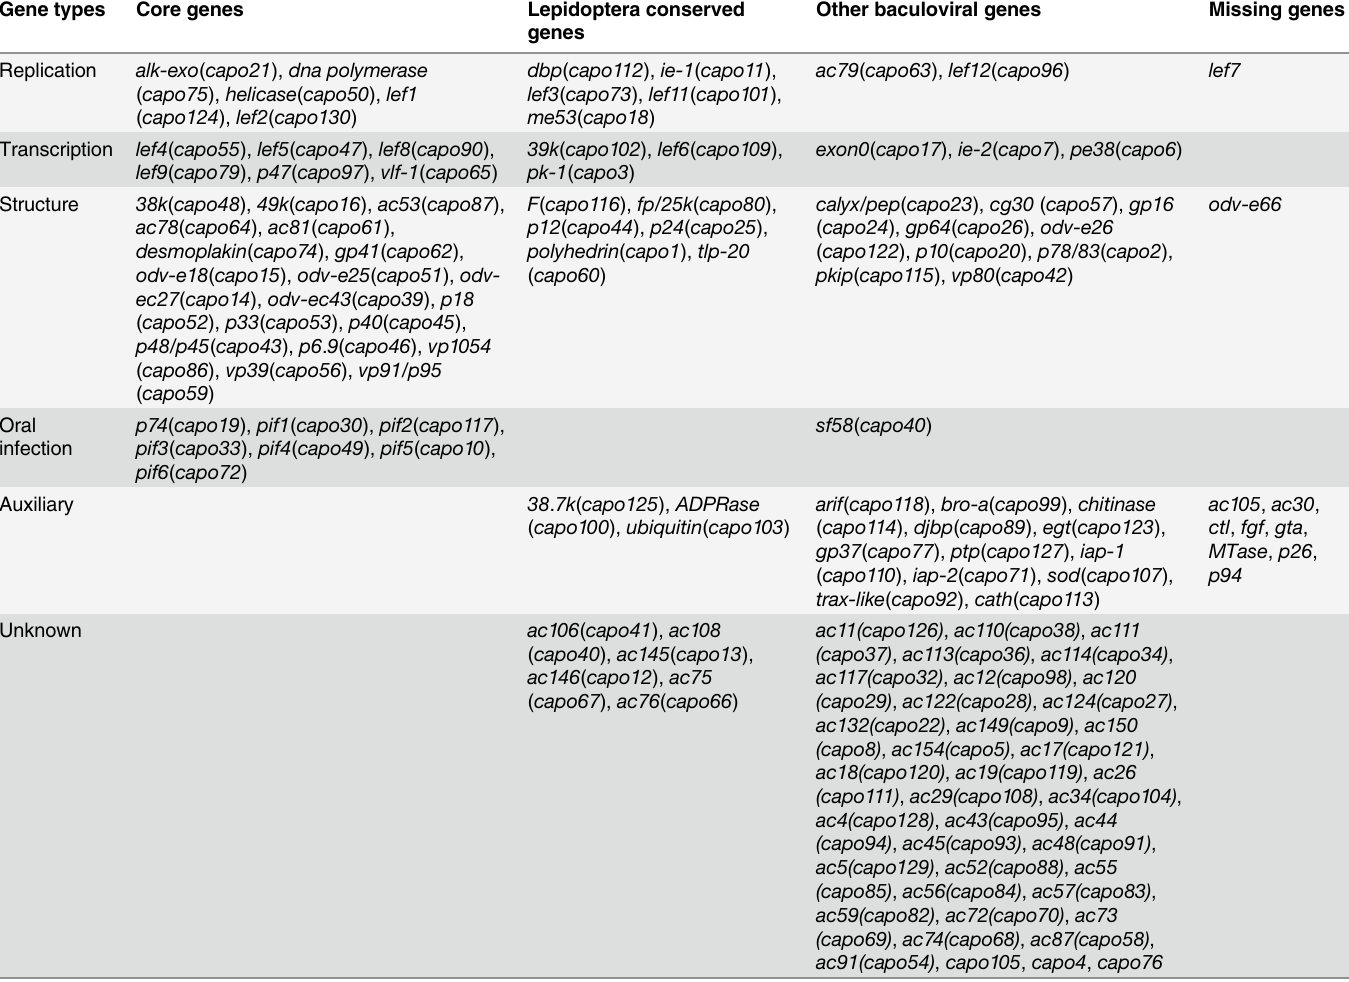
Table 1. Gene contents of CapoNPV *